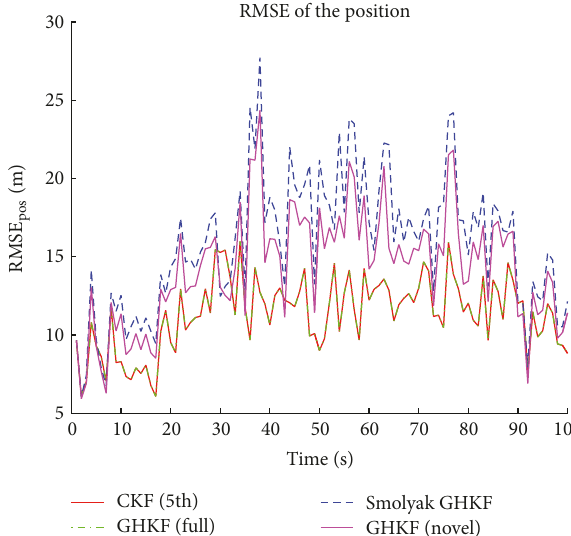
Figure 3: Estimation error of velocity (one simulation).